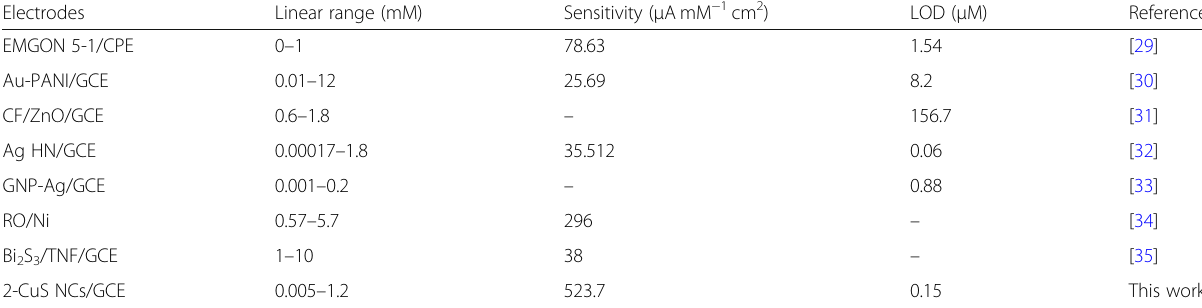
Table 1 Comparison of 2-CuS NCs/GCE with previously reported nonenzymatic AA sensors Electrodes